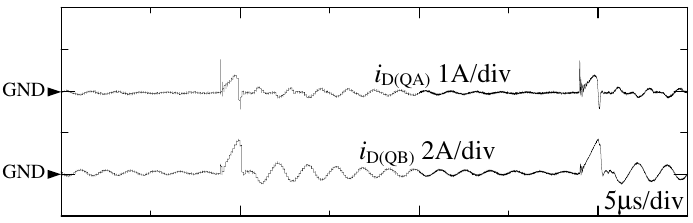
Figure 21. Experimental results of the output current I LED and voltage V oB for the reference LED current I ∗ . LED